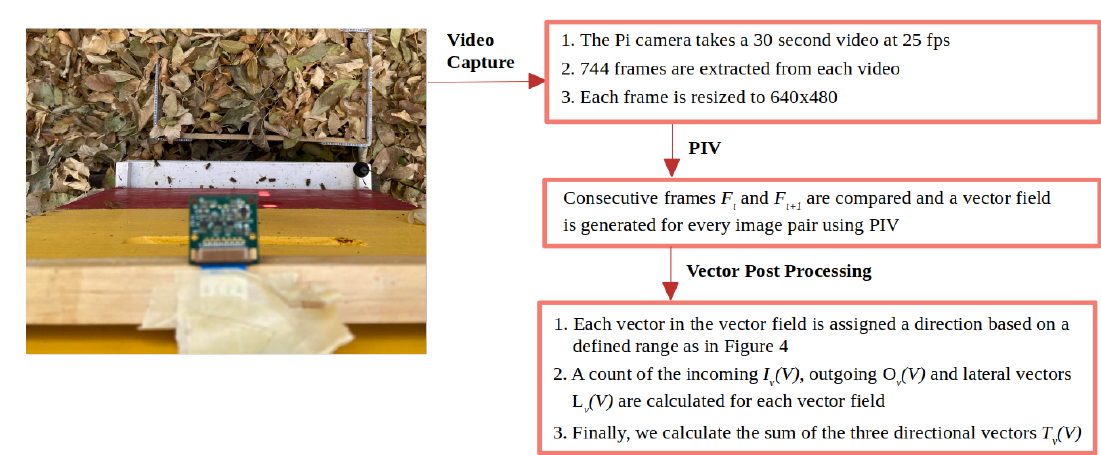
Figure 1. Directional DPIV-based bee motion estimation